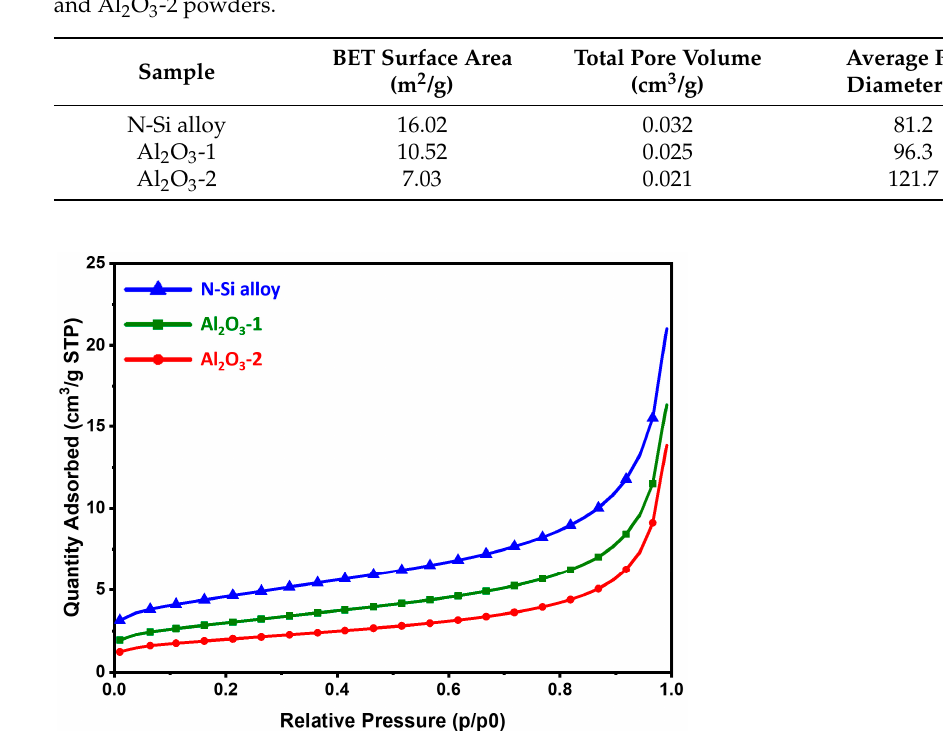
2 O 3 -1, and Al 2 O 3 -2